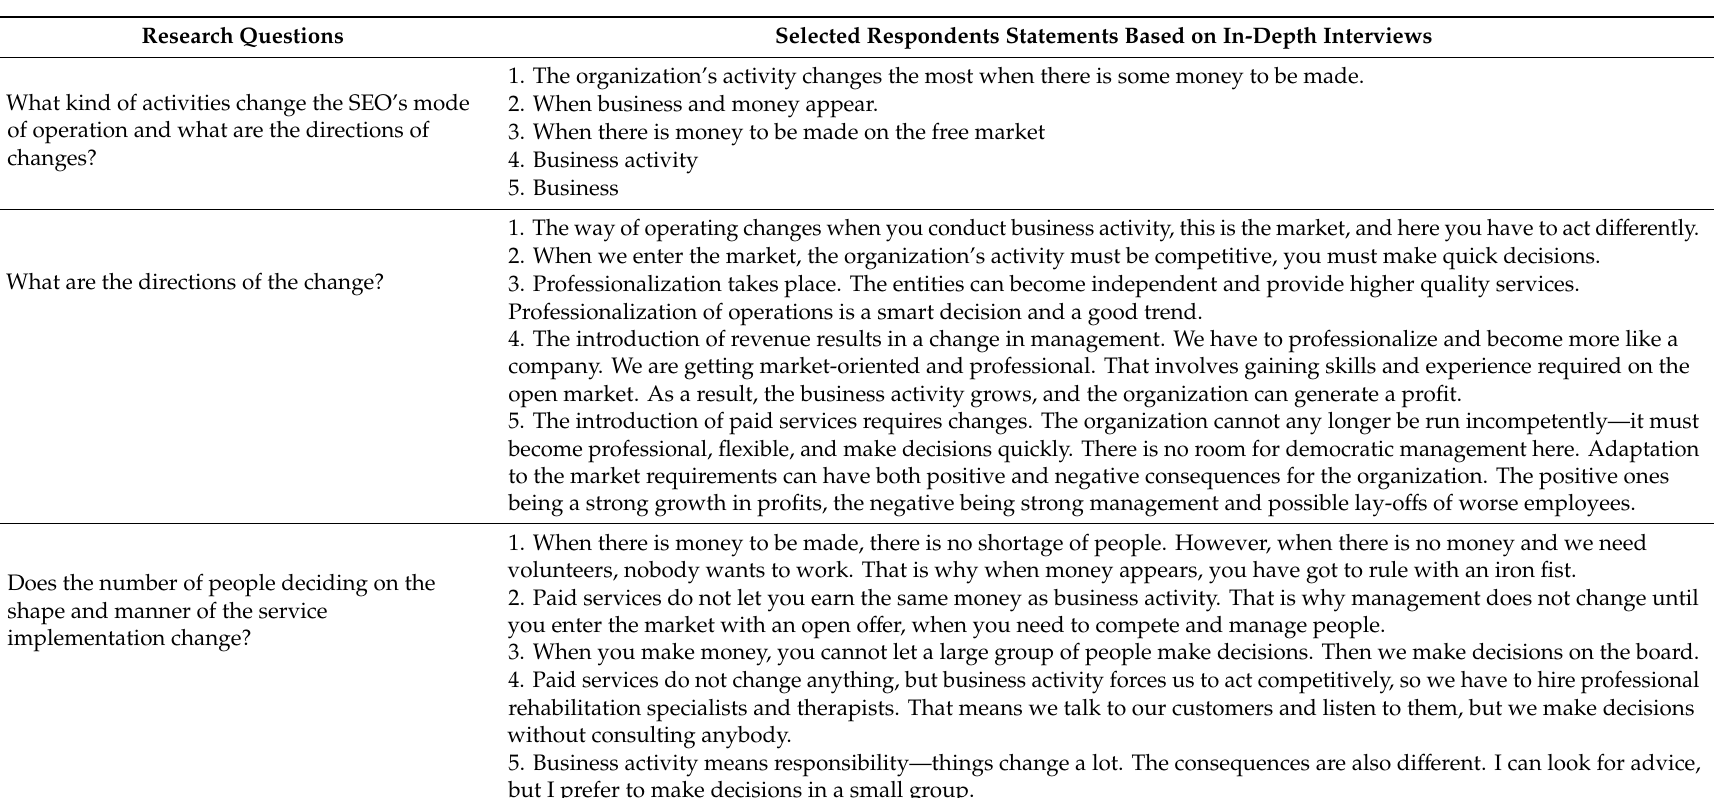
Table 2. Changes in SEOs’ activities and the scale of stakeholder engagement in the decision